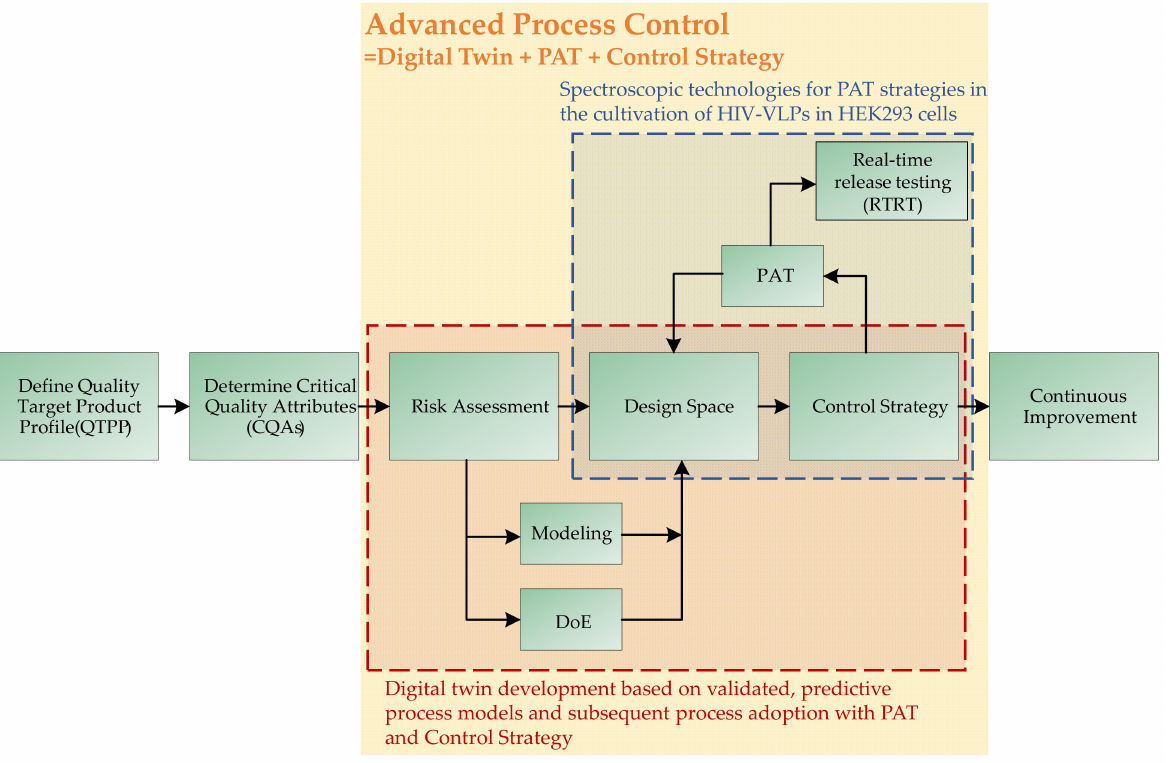
Figure 2. Workflow of model validation based on a QbD-oriented approach. In the first step, the QTPPs are defined. Subsequently, the CQAs are defined and a risk assessment of the influence of various process parameters on the CQAs is carried out. The risk assessment results in a design space for the process parameters to be investigated, which can be examined either via experiments or by means of a rigorous process model. Based on the results, a control strategy is defined, which can be continuously compared online via PAT with the actual state of the system. The strict implementation of this strategy allows continuous process